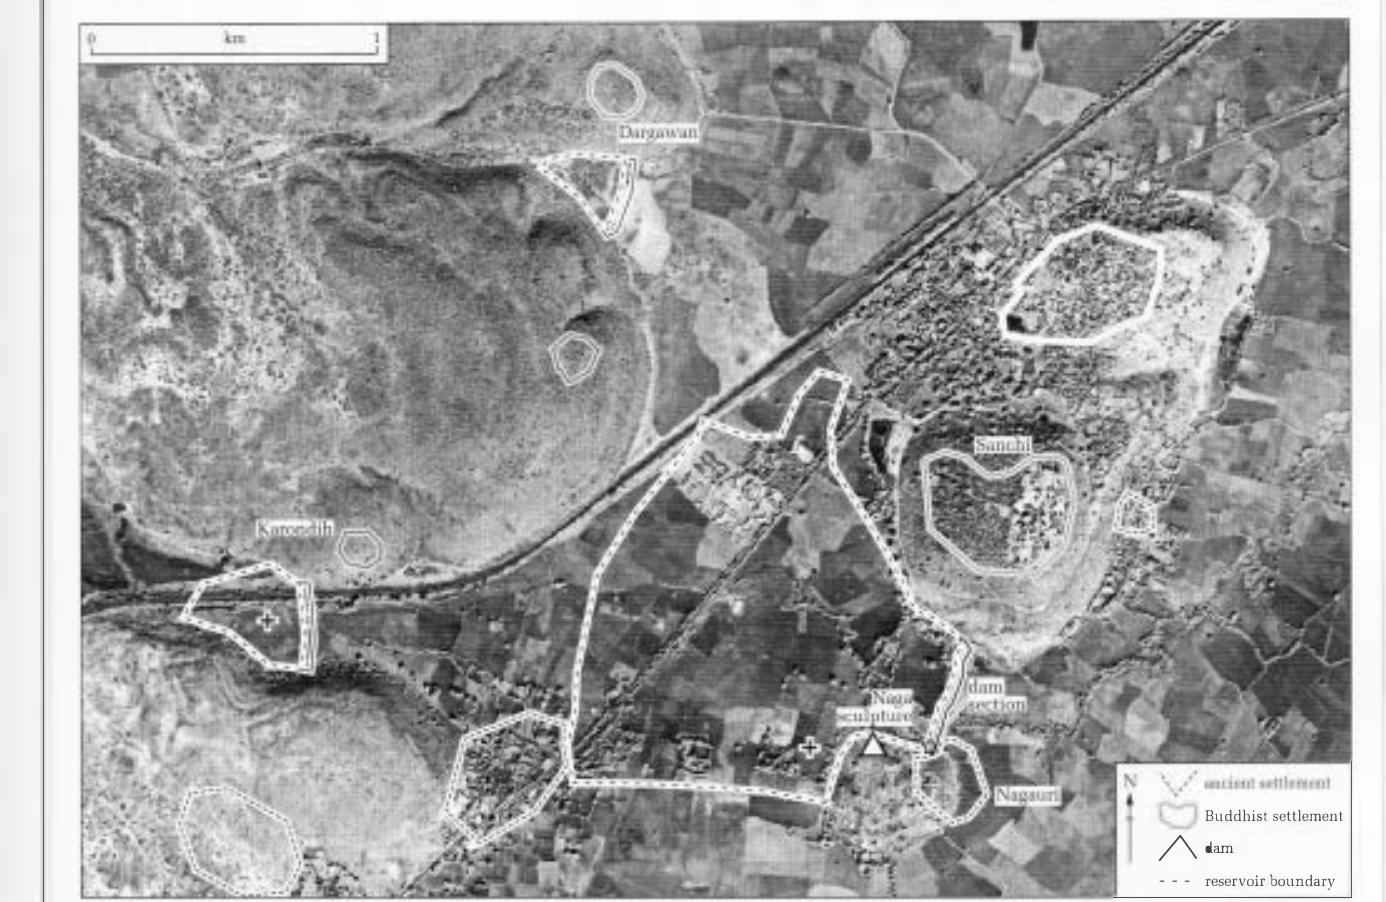
Figure 8 Quickbird satellite imagery of Sanchi Hill and its archaeological landscape: Buddhist sites, dams and reconstructed reservoir areas. dependent on centralized state administra­ tion. Marxist-inspired models, as